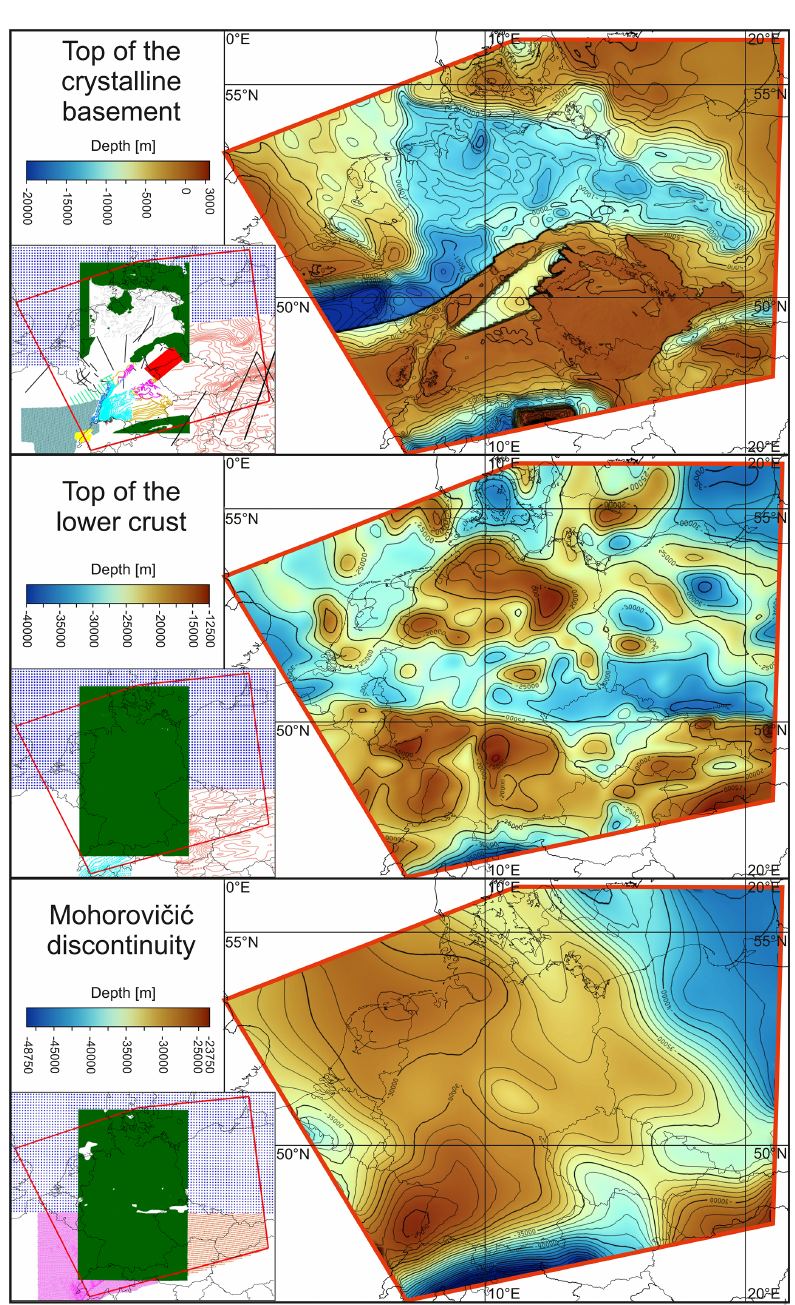
Figure 4. Database and depth maps of the top of the crystalline basement, the top of the lower crust and the Mohoroviˇci´c discontinuity. We used the color map “roma” of Crameri (2021). Sources of used data are as follows. Crystalline basement: Anikiev et al. (2019) (dark green), Diebold et al. (1991) (brown), GeORG-Projektteam (2013) (light blue), Geothermieatlas Bayern (2004) (pink), Hurtig et al. (1992) (blue green), Kirsch et al. (2017) (red), Korsch and Schäfer (1995) (light green), Lindner et al. (2004) (grey), Maystrenko and Scheck- Wenderoth (2013) (dark blue), Reinhold (2005) (orange), Rupf and Nitsch (2008) (cyan), Sommaruga (1999) (yellow), Tašárová et al. (2016) (light red), and black profiles (Behr et al., 1994; Bokelmann and Bianchi, 2018; Cazes et al., 1985; Freeman and Mueller, 1992; Grad et al., 2009a; Heinrichs et al., 1994; Hirschmann, 1996; Janik et al., 2011; Meschede and Warr, 2019; Oncken et al., 2000; Reinhold, 2005; Schintgen, 2015; Wenzel and Brun, 1991). A labeled, larger size map of this database is available in the Supplement. Top of the lower crust: Anikiev et al. (2019) (dark green), Maystrenko and Scheck-Wenderoth (2013) (dark blue), Tašárová et al. (2016) (light red), and Valasek and Mueller (1997) (cyan). Mohoroviˇci´c discontinuity: Anikiev et al. (2019) (dark green), Grad et al. (2009b) (red), Maystrenko and Scheck-Wenderoth (2013) (dark blue), and Wagner et al. (2012) (pink). Coastlines and borders used in the figures are based on the Global Self-consistent Hierarchical High-resolution Geography (GSHHG) of Wessel and Smith